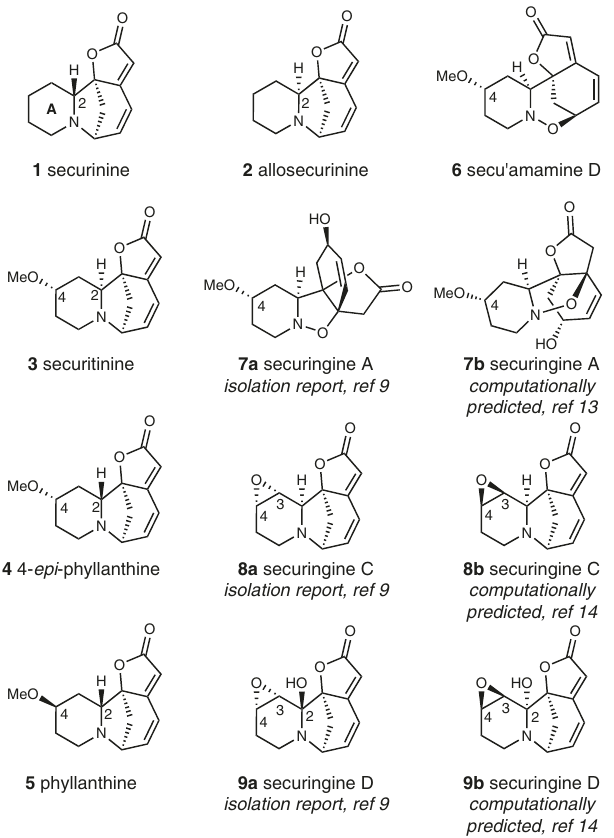
Fig. 1 | Representative securinine-type natural products of our interest. Struc- tures of securinine, allosecurinine, and representative C4-oxygenated securinine- typenaturalproductsaredepicted. Boththeoriginallyproposedstructureand the computationally predicted structure are presented for securingines A, C, and